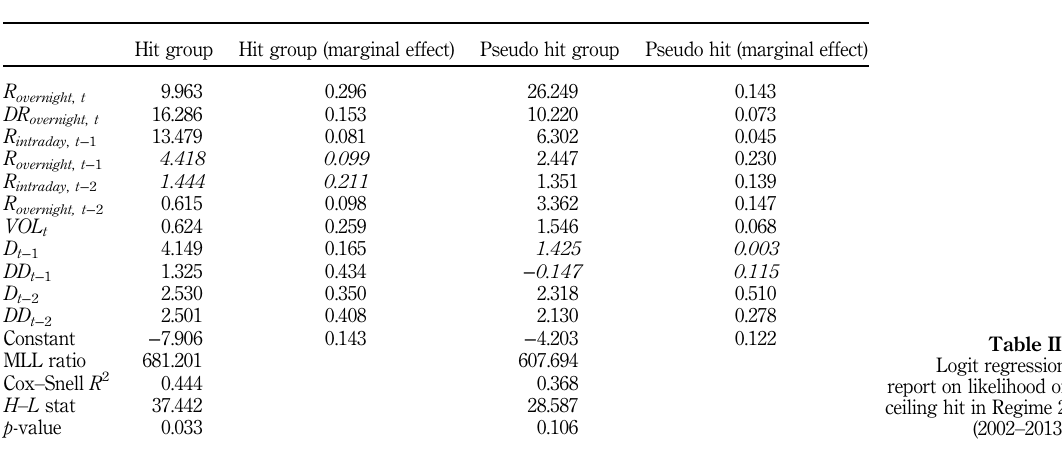
Table I. Logit regression report on likelihood of ceiling hit (Regime